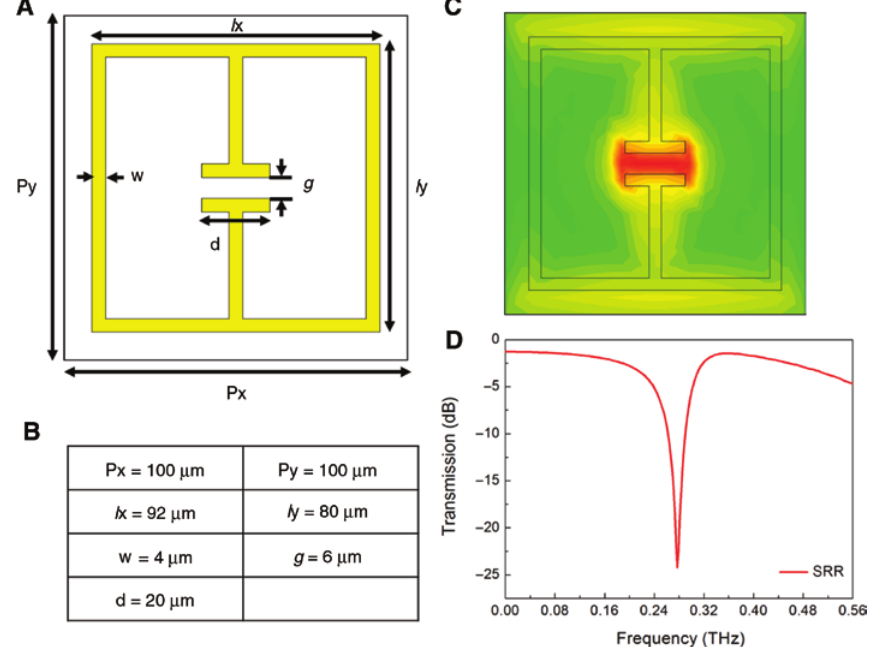
Appendix-Figure 2: Simulation detail of SRR: (A) 2D structure model, (B) structural parameters, (C) electrical field distribution, and (D) transmission